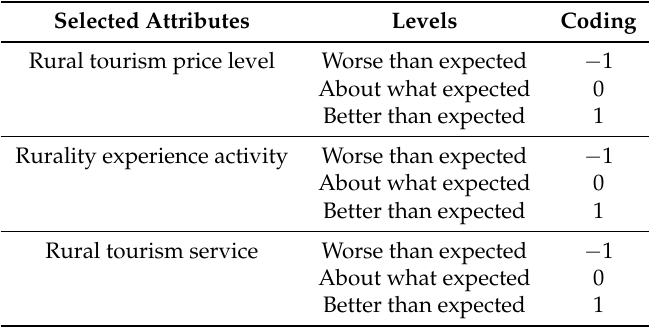
Table 2. Rural tourism product attributes and levels.